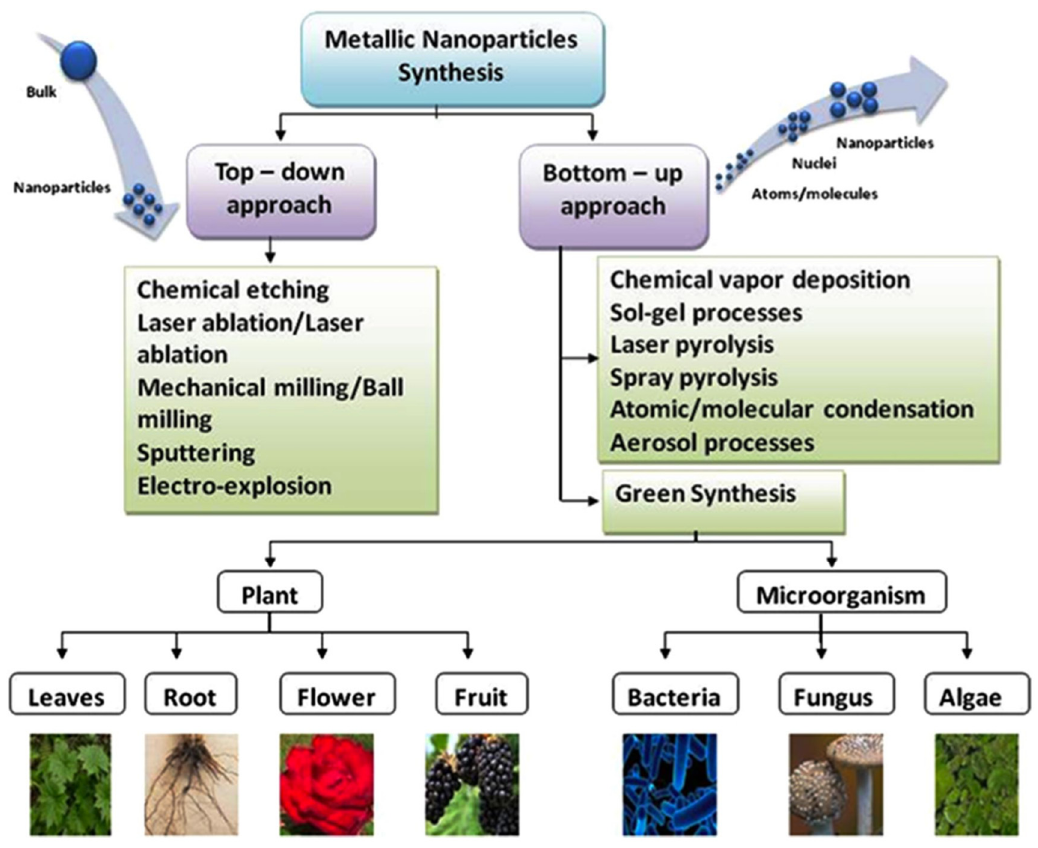
Figure 3. Top-down and bottom-up approaches for the fabrication of metal-based nanoparticles